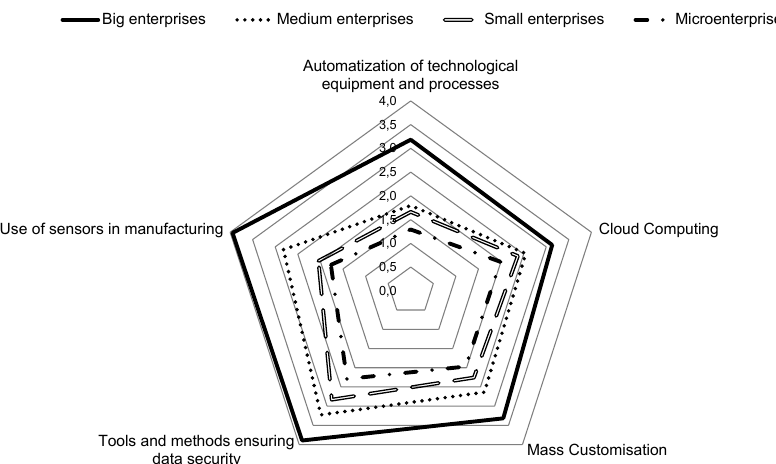
Fig. 3 – Most common elements and tools of Industry 4.0 used by Czech engineering enterprises. Source: Survey questionnaire